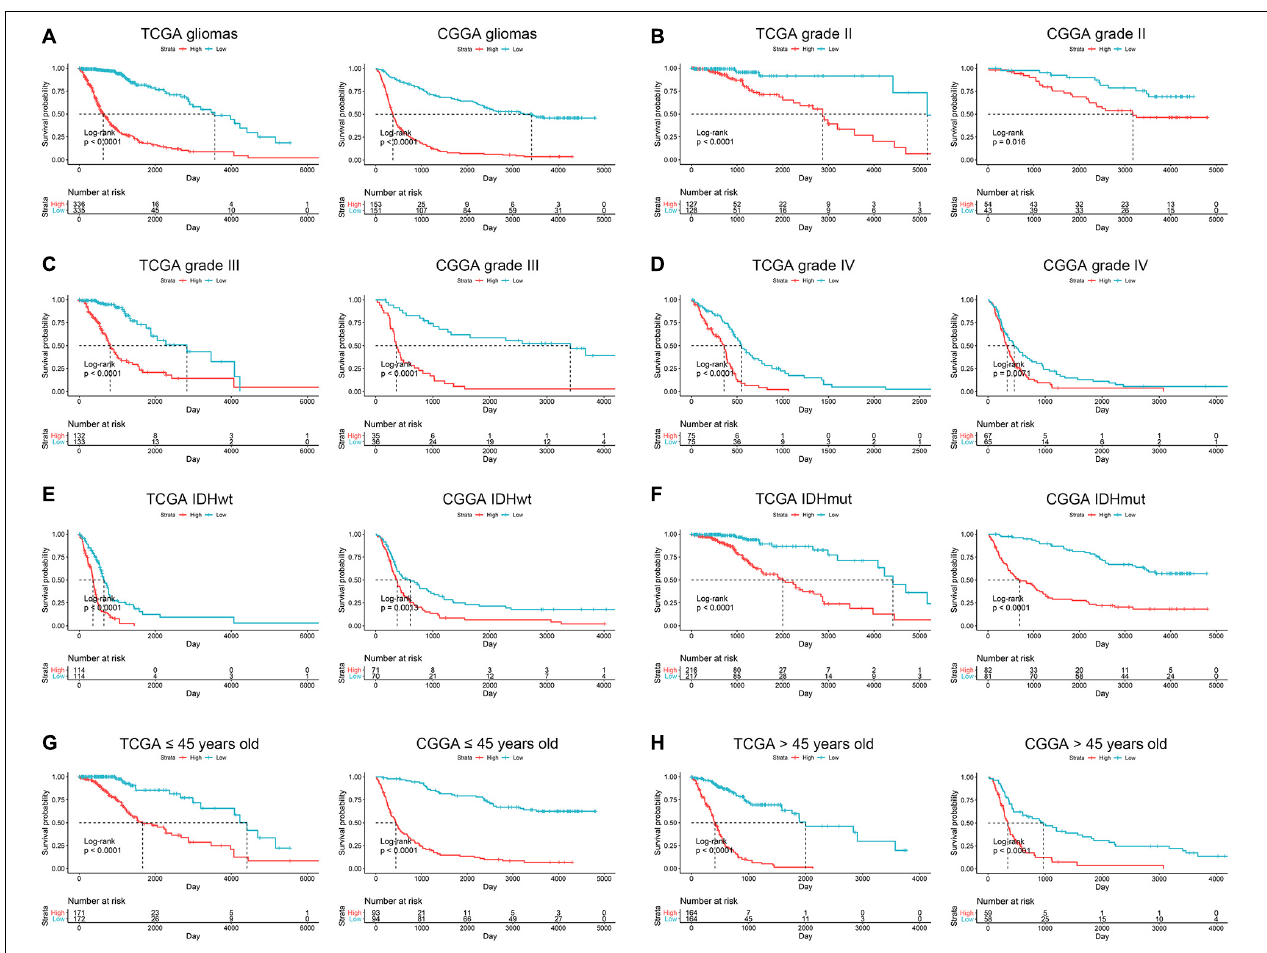
FIGURE 6 | ARL score indicated the prognosis in different subgroups of glioma patients. (A) Kaplan-Meier analysis of high-score and low-score patients in diffuse gliomas. (B–D) Kaplan-Meier analysis of high-score and low-score patients in grade II (B) , grade III (C) , and grade IV (D) gliomas. (E,F) Kaplan-Meier analysis of high-score and low-score patients in IDH1 wildtype (E) and IDH1 mutant (F) gliomas. (G,H) Kaplan-Meier analysis of high-score and low-score patients ≤ 45 years old (G) or > 45 years old (H) in diffuse gliomas.